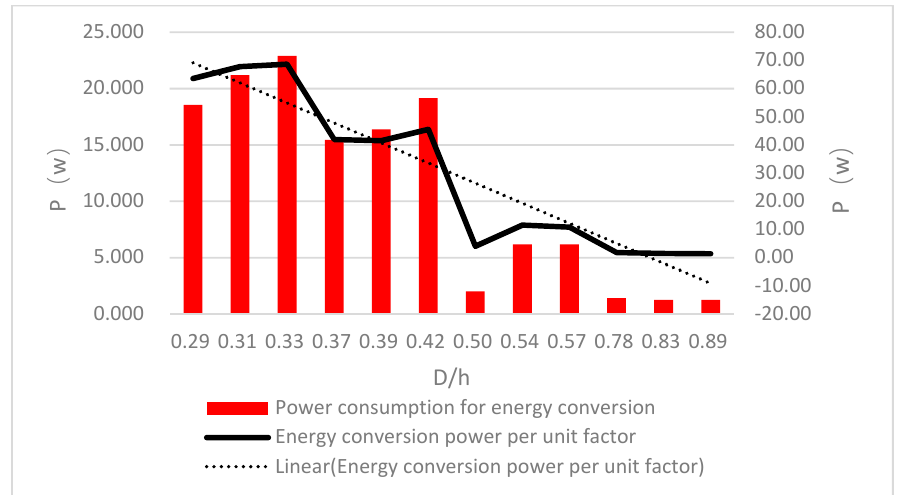
Figure 15. Experimental data graph.